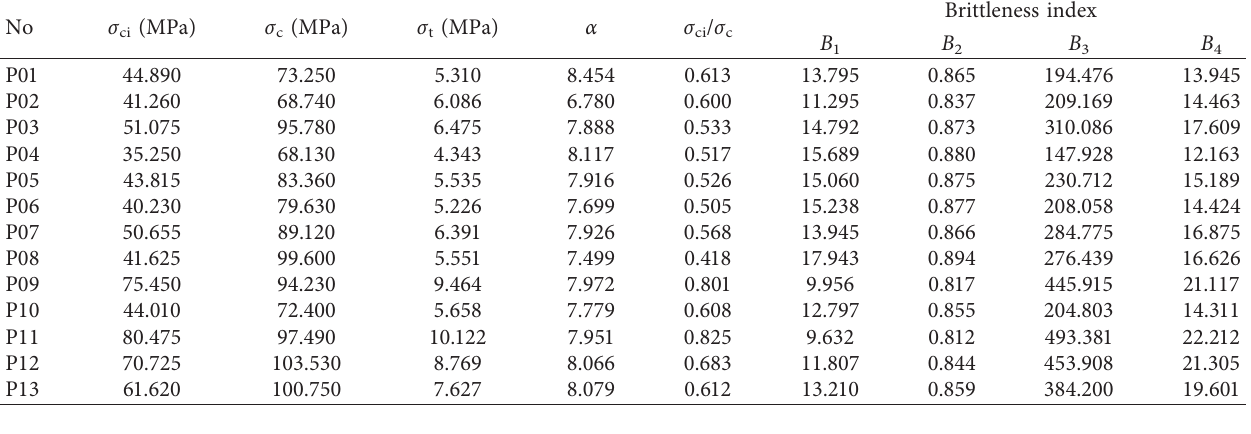
Table 2: Summary of mechanical parameters of gneiss samples.